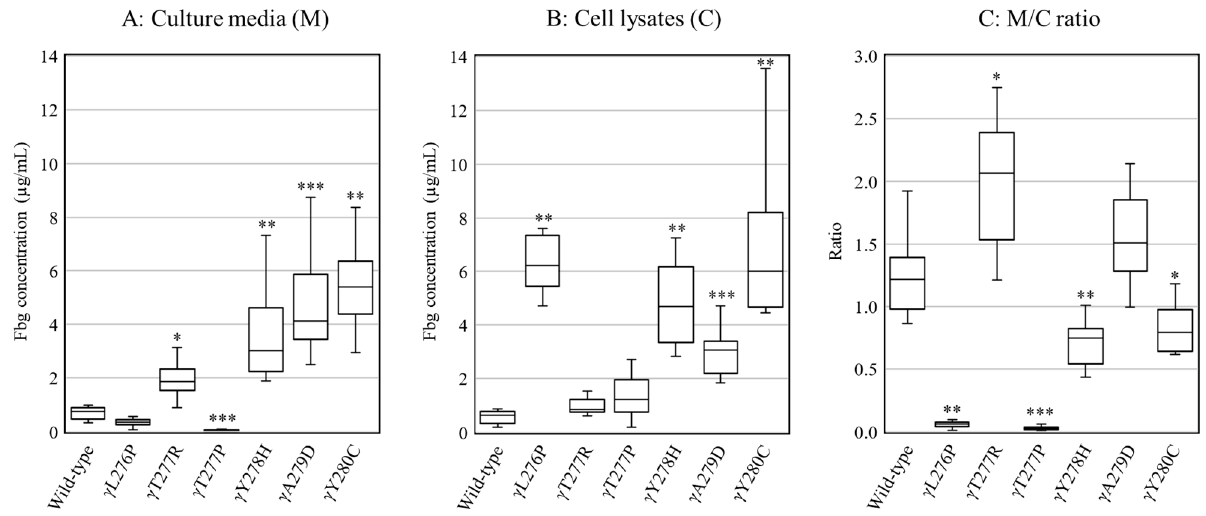
Figure 2. Secretion and synthesis of fibrinogen in Chinese hamster ovary cells. Fibrinogen concentrations in the culture media ( A ) and cell lysates ( B ) were measured using an enzyme-linked immunosorbent assay. Panel ( C ) shows the M/C ratio of the culture media to the cell lysate. Box plots and central bars show the interquartile range and median, respectively. The significance of differences between wild-type and variant fibrinogen-producing cells is shown (* p < 0.05, ** p < 0.01, *** p < 0.001).